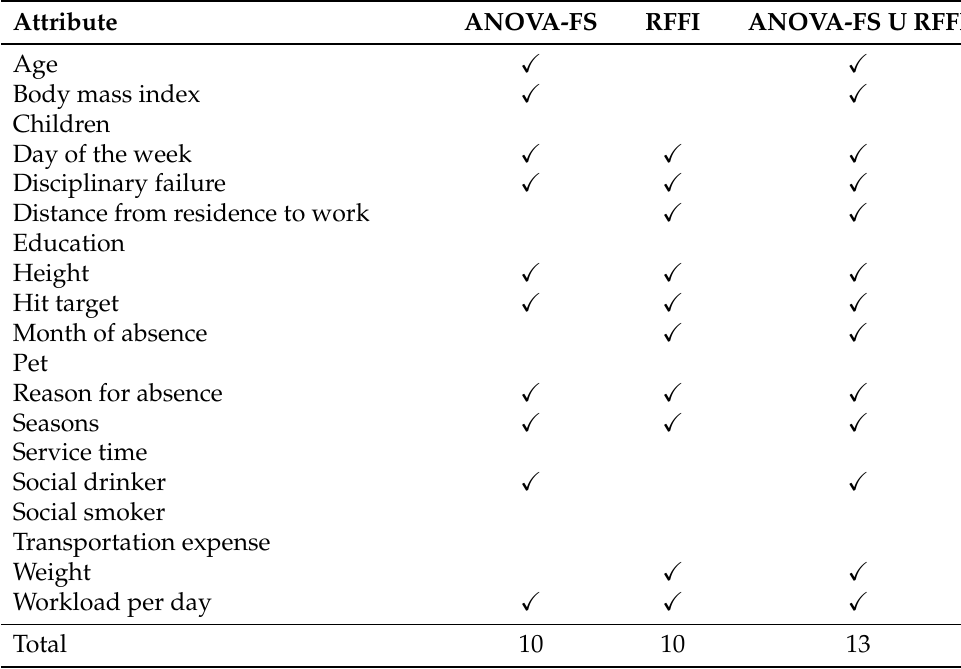
Table 1. Feature importance as determined by Random